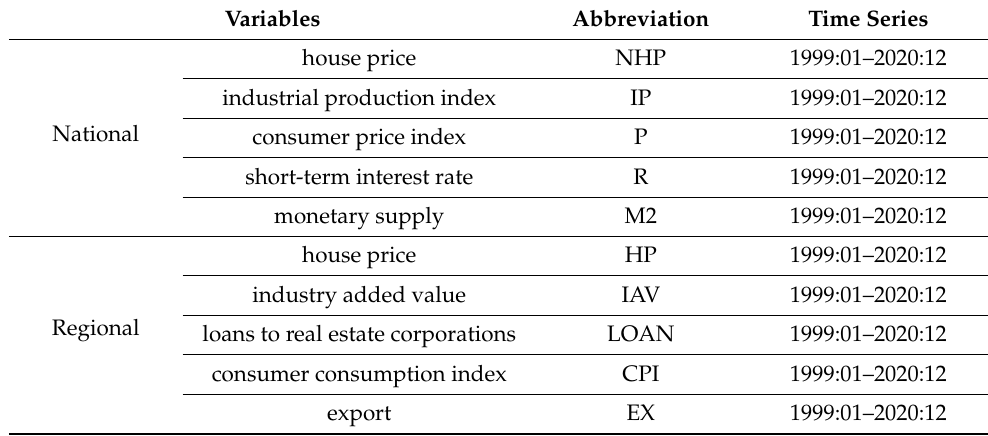
Table 3. Variable descriptions.